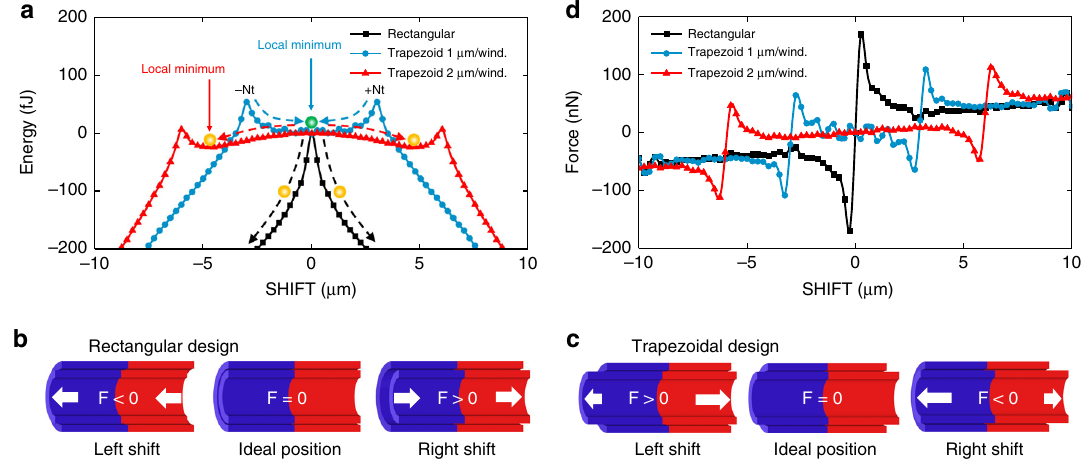
Fig. 2 In fl uence of nanomembrane planar design on energy and force during assembly. a Magnetostatic energy as a function of shift for the rectangular design and the trapezoidal design with different pitch at three windings. Change from rectangular to trapezoidal pattern results in the formation of energy plateaus with new local minima. The speci fi c shape of energy plateaus and the position of minima can be in fl uenced by the trapezoid pitch. b Direction of axial forces F depending on shift for two adjacent windings in the rectangular design. c Same as in b but for trapezoidal design. d Forces as a function of shift for the rectangular design and the trapezoidal design with different pitch at three windings